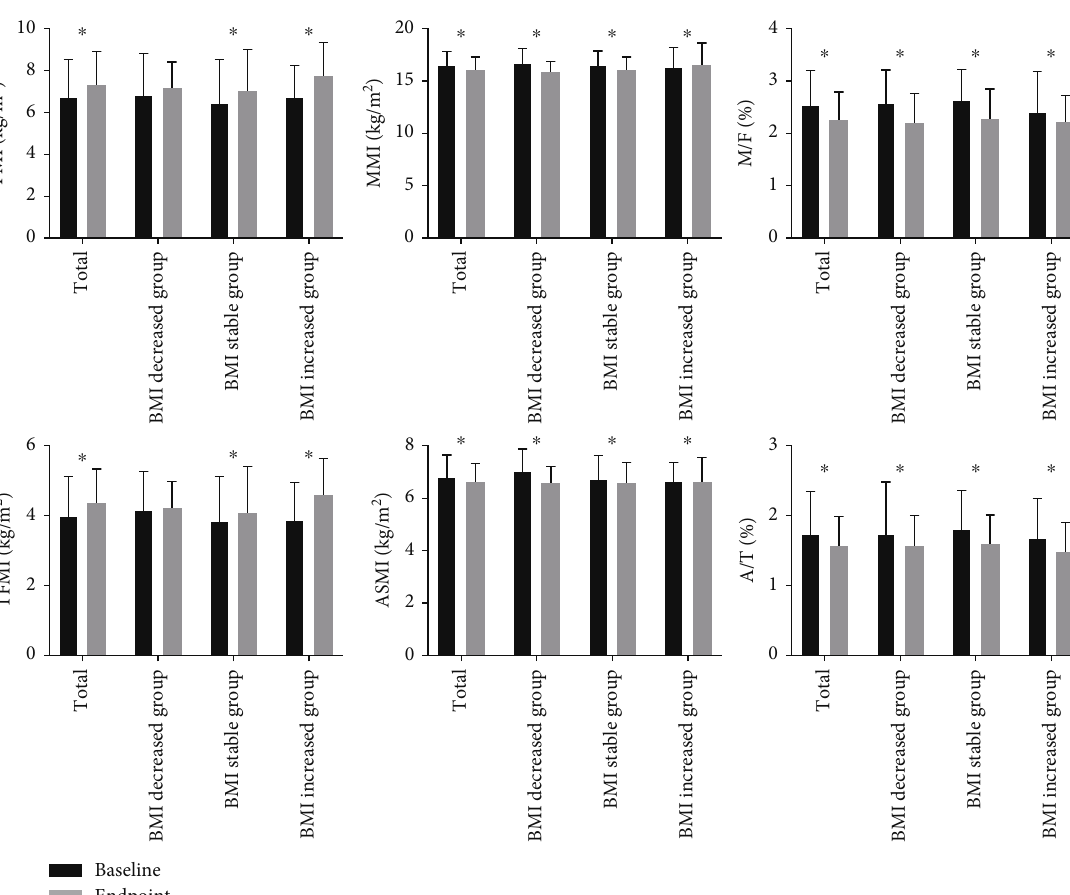
Figure 1: Bar graphs of body composition index and constituent ratio in 596 T2DM patients before and after follow-up. Note: FMI: fat mass index; MMI: muscle mass index; M/F: muscle/fat mass ratio; TFMI: trunk fat mass index; ASMI: appendicular skeletal muscle mass index; A/T: appendicular skeletal muscle mass/trunk fat mass